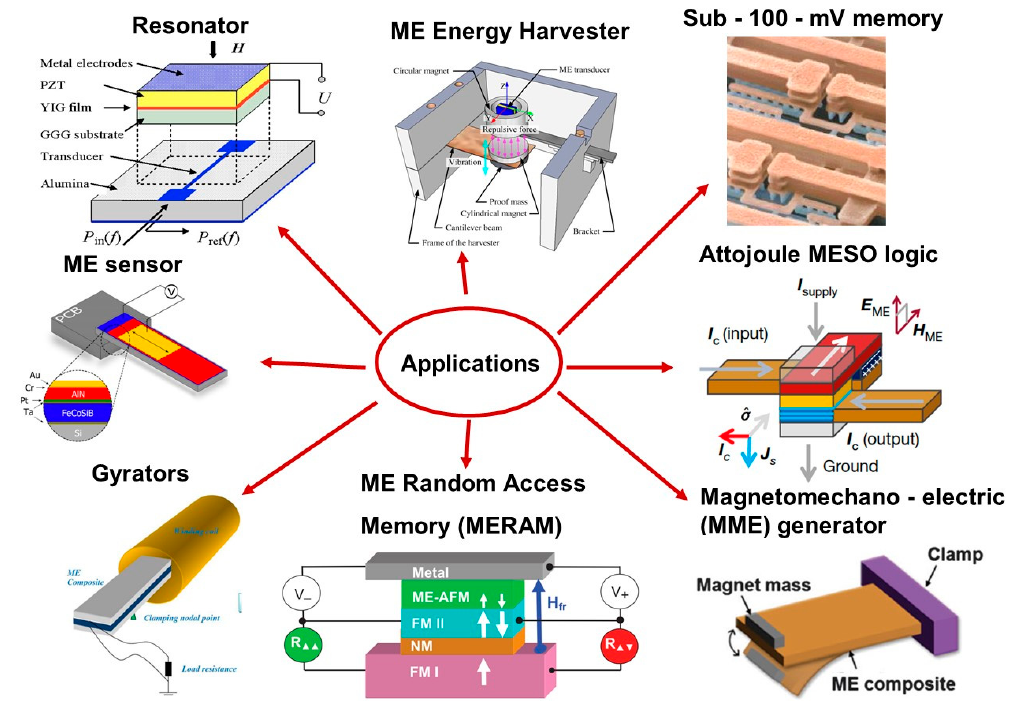
Figure 1. Various applications of magnetoelectric (ME) composites. Figures reproduced with permission from [9,39–41,43–45] .